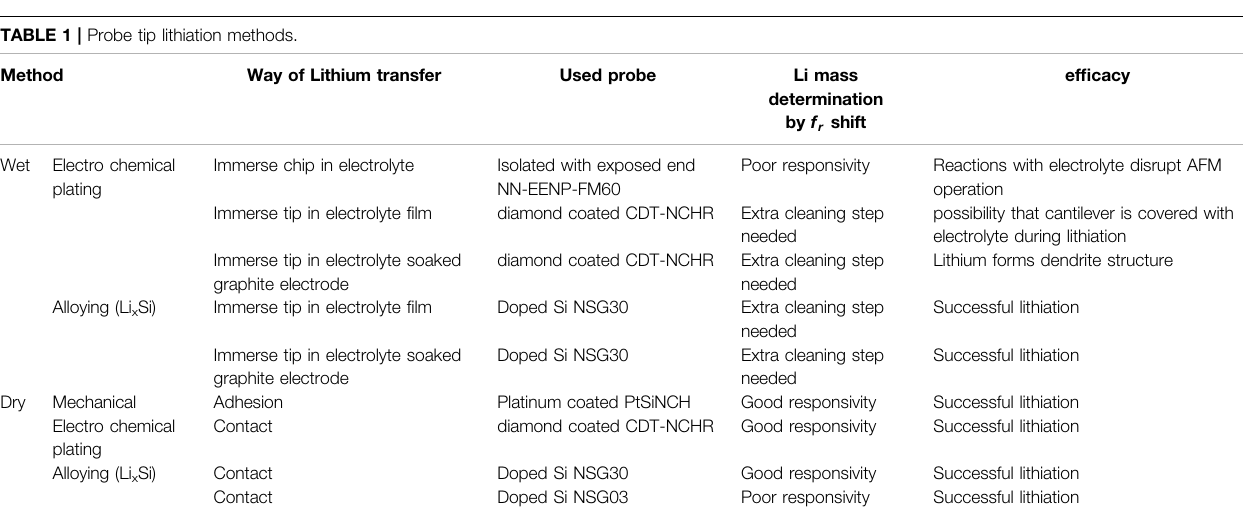
TABLE 1 | Probe tip lithiation